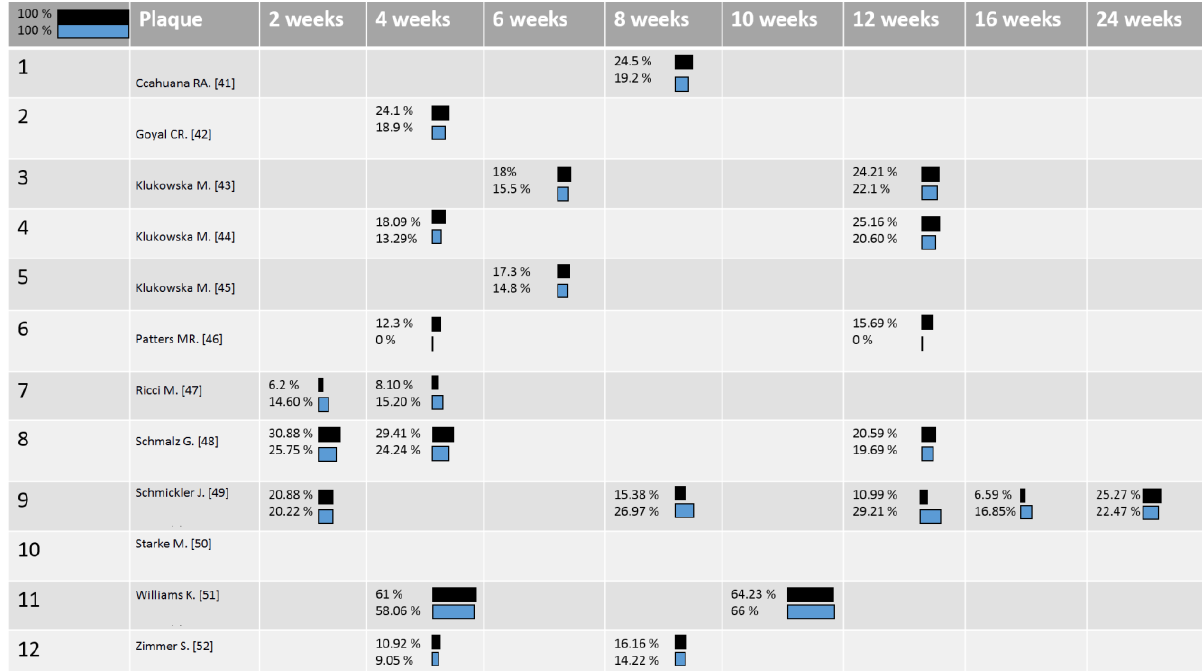
Figure 3. Bleeding Index, the mean values of Bleeding Index (changes) in relation to the number of patients in each study at each time-point: blue color corresponds to ORHs and black to SAHs toothbrushes [41–52].